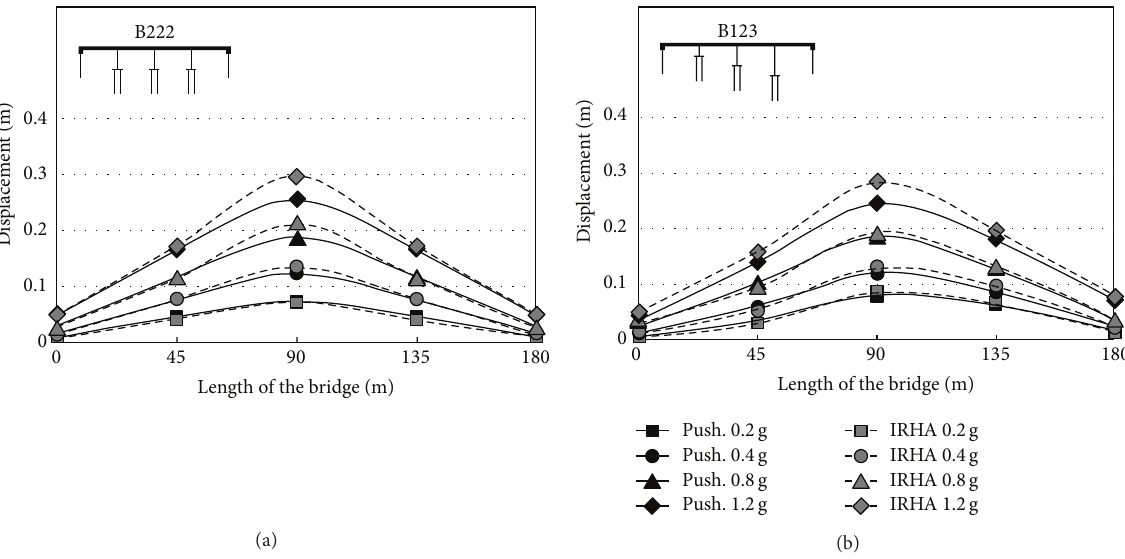
Figure 10: The deck displacement pattern of B222 and B123 under Tabas record (PGA = 0.2g − 1.2